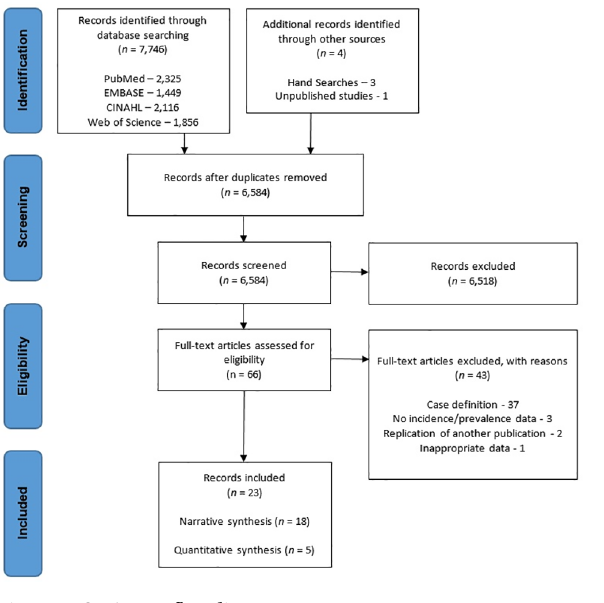
Fig 1. PRISMA 2009 flow